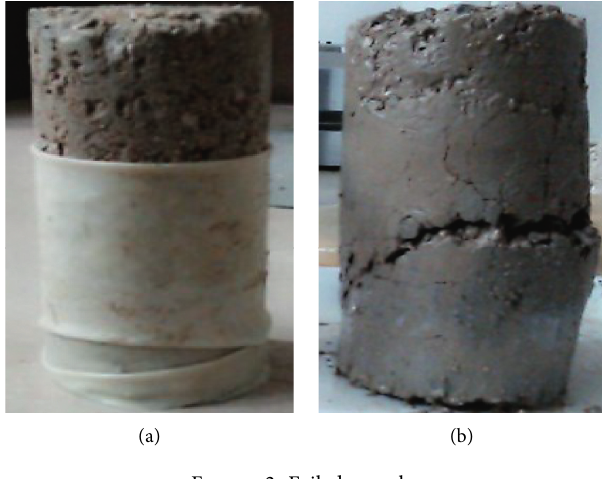
Figure 2: Failed sample.